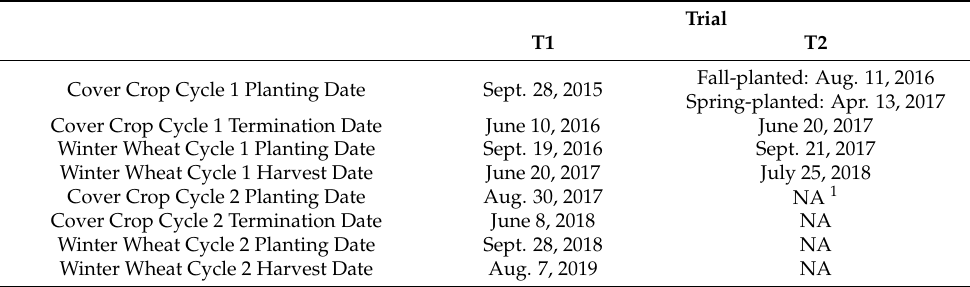
Table 2. Planting, cover crop termination and winter wheat harvest dates for Trials 1 (T1) and 2 (T2) at the Southwestern Colorado Research Center in Yellow Jacket,